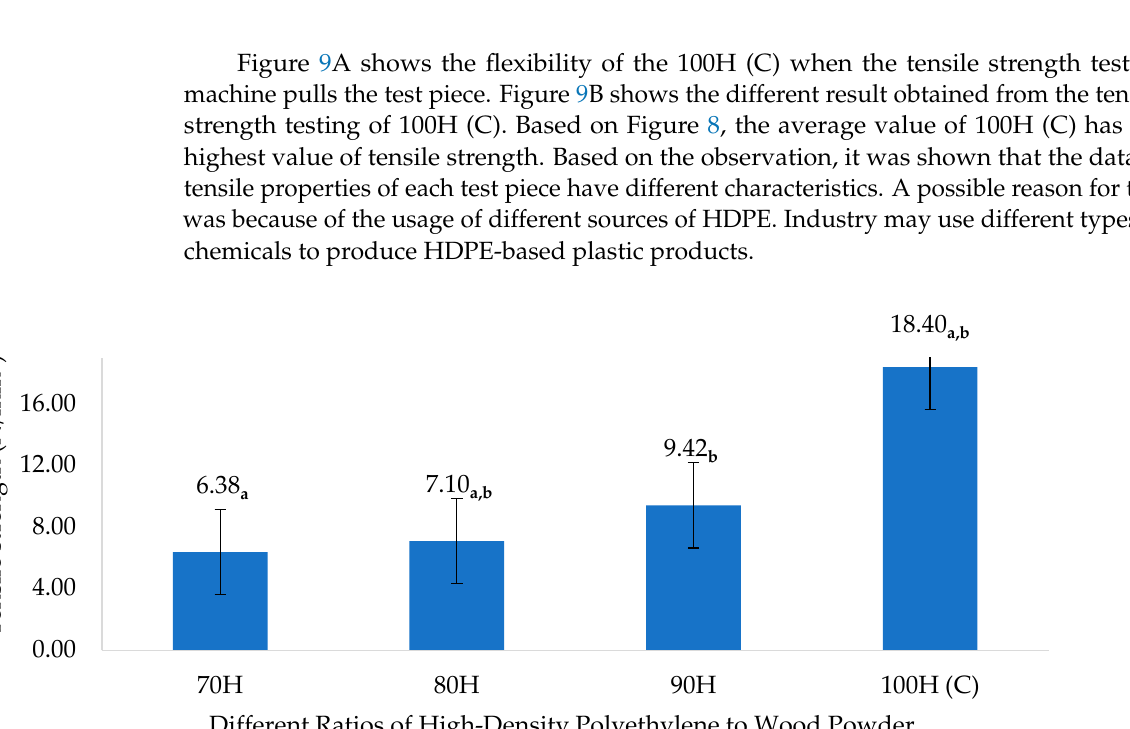
Figure 8. Average tensile strength of WPC at different ratio of HDPE and wood powder with different alphabets (a, and b) displayed beside the average values show significant differences among the parameters.